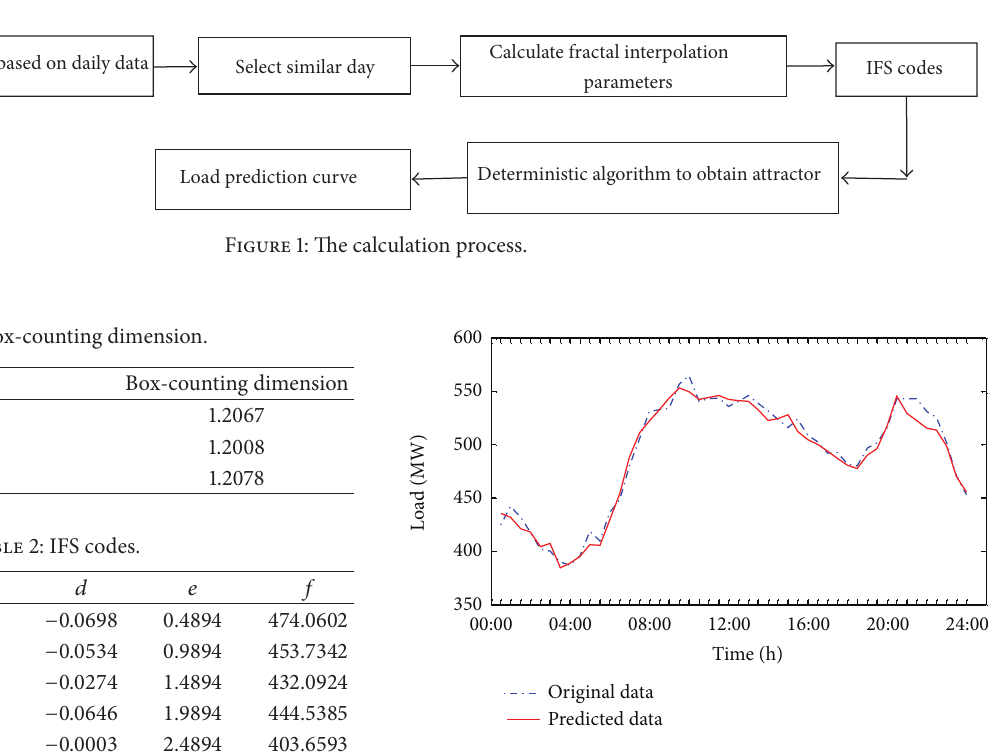
Figure 2: Actual and predicted daily load